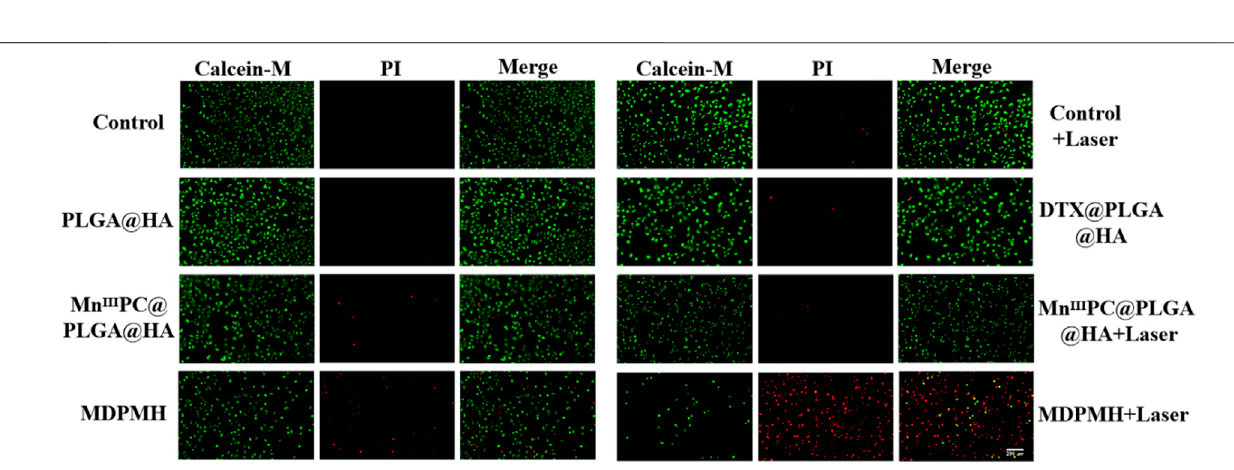
Frontiers in Pharmacology |